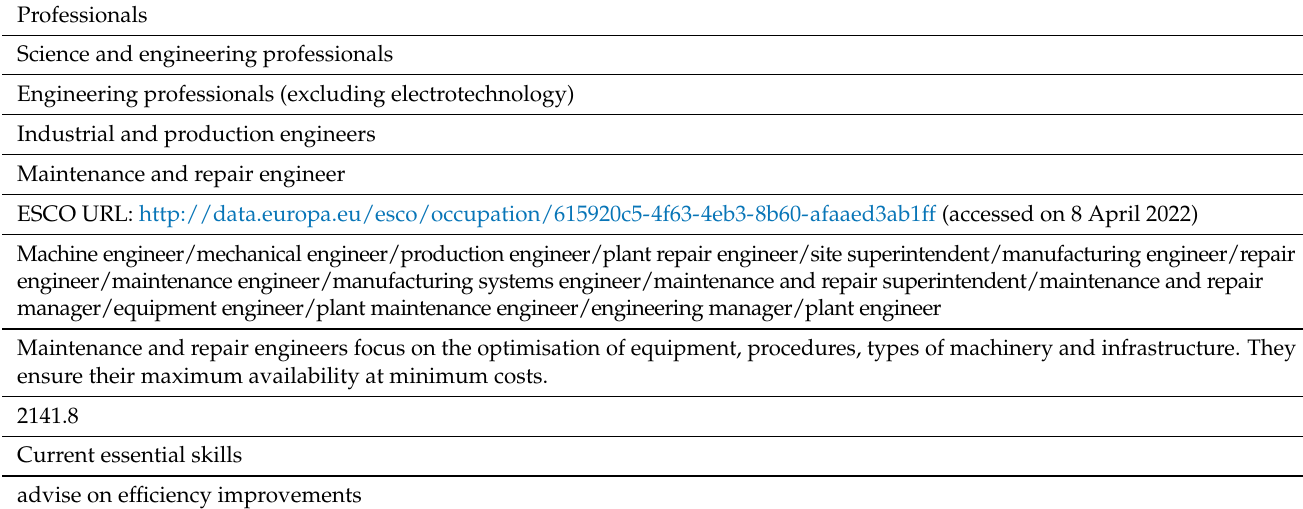
Table 7. The view of an example sheet from the database: “Maintenance and repair